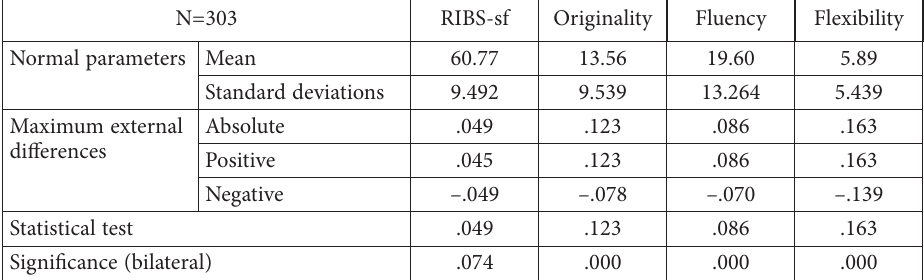
Table 2. Kolmogorov–Smirnov test for one sample (source: created by authors) N=303 RIBS-sf Originality Fluency Flexibility Normal parameters Mean 60.77 Standard deviations Maximum external Absolute .049 differences Positive .045 Negative –.049 –.139 Statistical test .049 .123 .086 .163 Significance (bilateral) .074 .000 .000